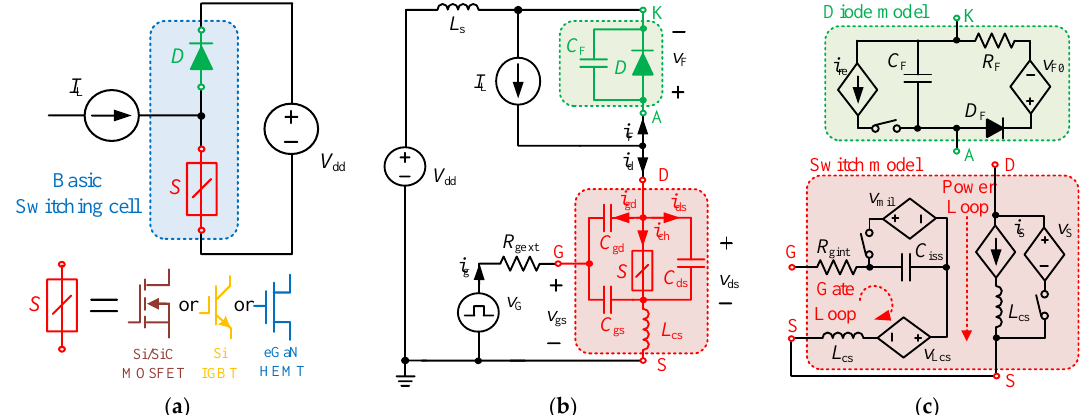
Figure 1. Schematic diagrams of ( a ) switch-diode cell circuit; ( b ) DPT circuit; ( c ) Proposed switch and diode models.